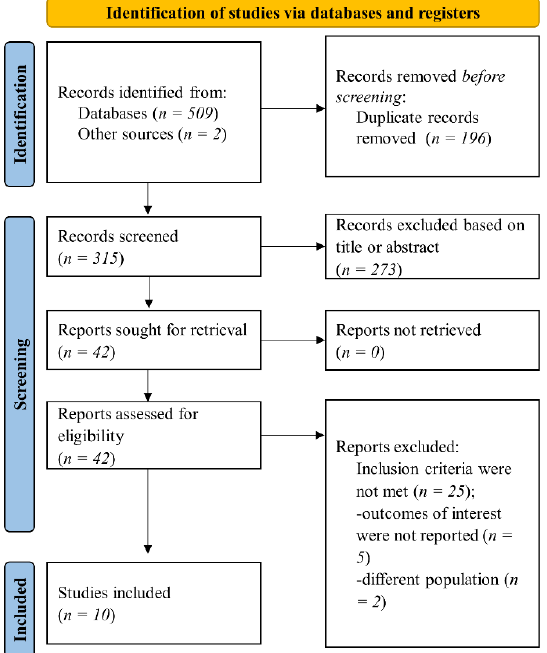
Figure 1. Flow diagram of selected studies in the present analysis. Table 1. General characteristics of studies included in the present systematic